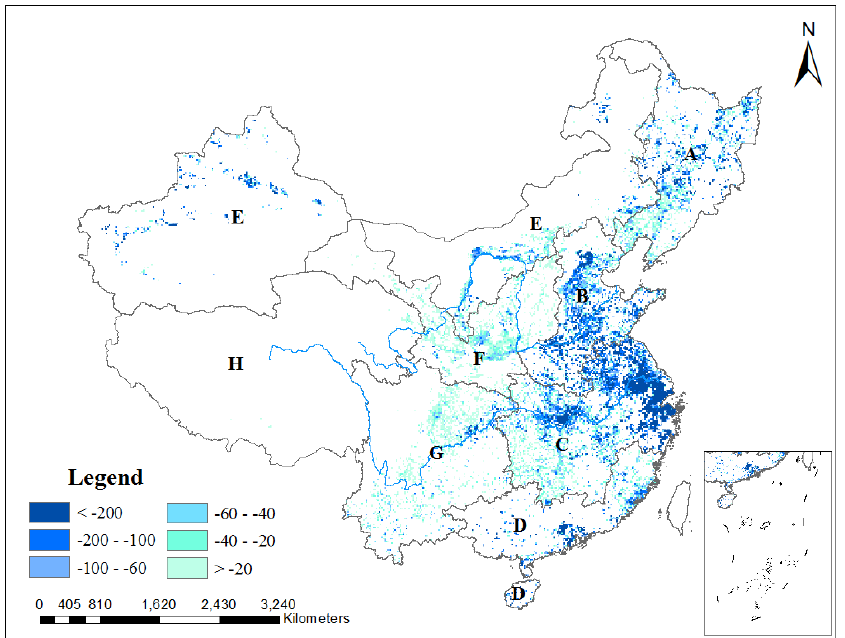
Figure 6. Decrease in CR (t/10 km 2 ).